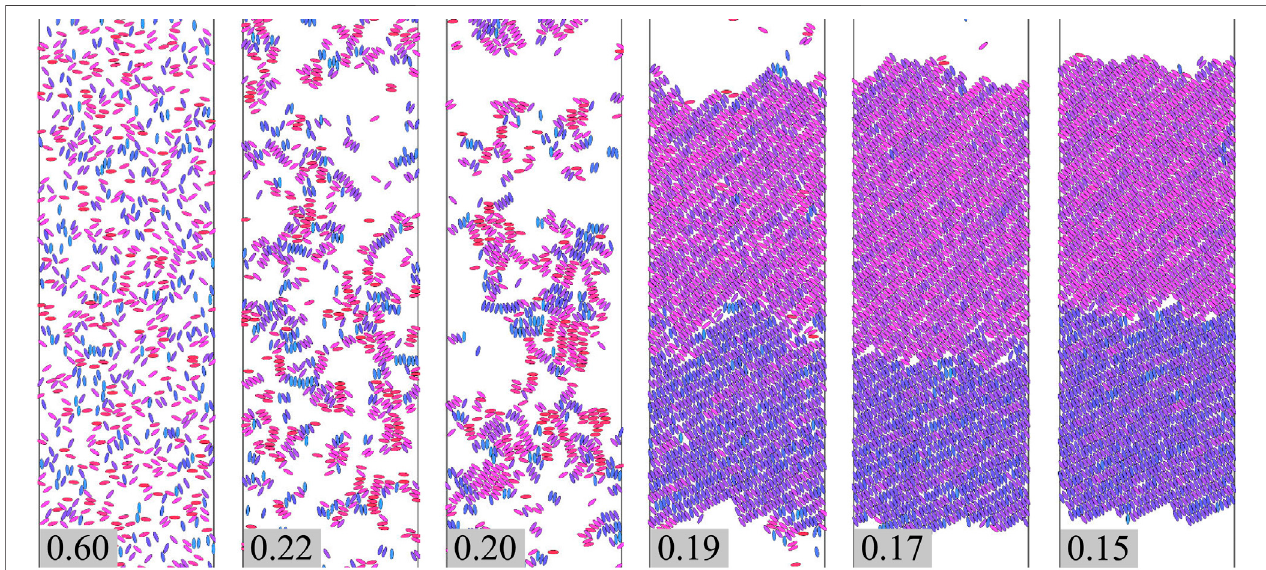
FIGURE 6 | A representative cooling sweep in the NAT ensemble. Con fi gurations are shown for an ensemble with N (cid:2) 2 , 000 and ρ p (cid:2) 0 . 10. The temperature T p decreases going from left to right over a narrow temperature window as shown. Snapshots of the simulation box have been trimmed to improve the visual clarity of the more densely populated regions observed at lower